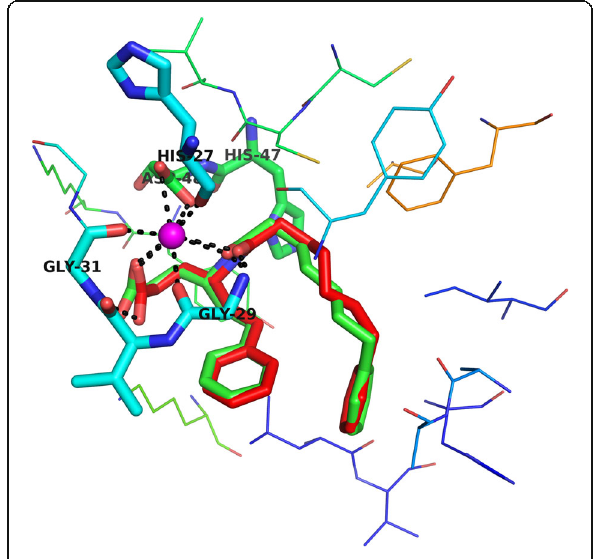
Fig. 4 The superimposition of the best docking structure with the X-ray structure visualized in PyMOL; (